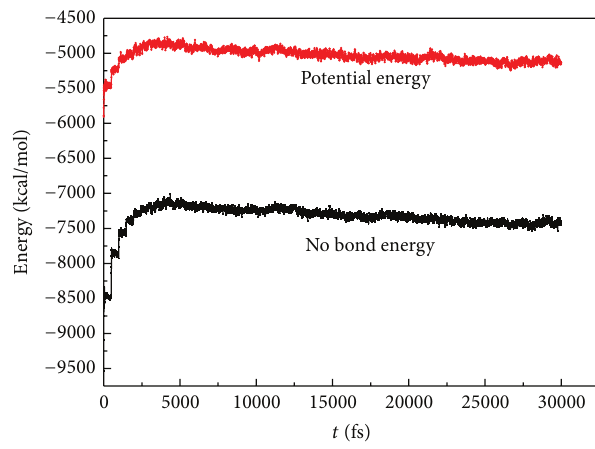
Figure 3: Energy with the system optimization.